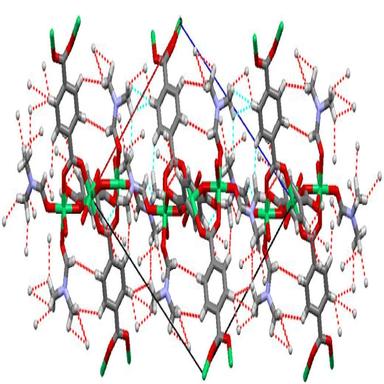
Illustration of the one-dimensional H–H interaction in the chain structure. Dotted lines indicate H–H interactions.